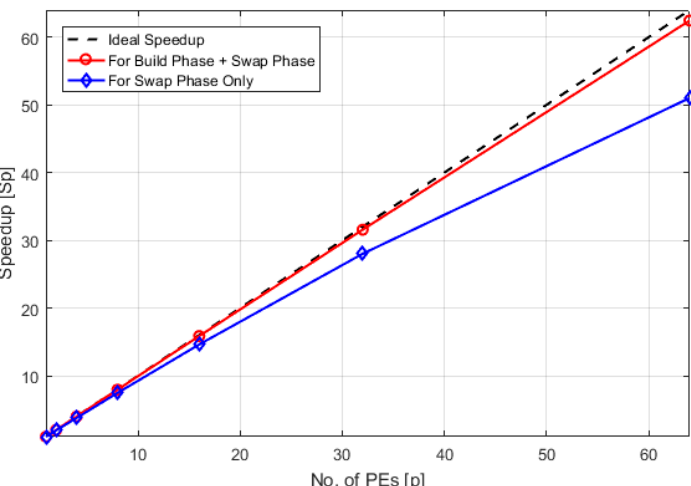
Figure 7. Comparison of speedup for the case when medoids are initialized using the build phase with the case when medoids are randomly initialized, data size is same in both cases.